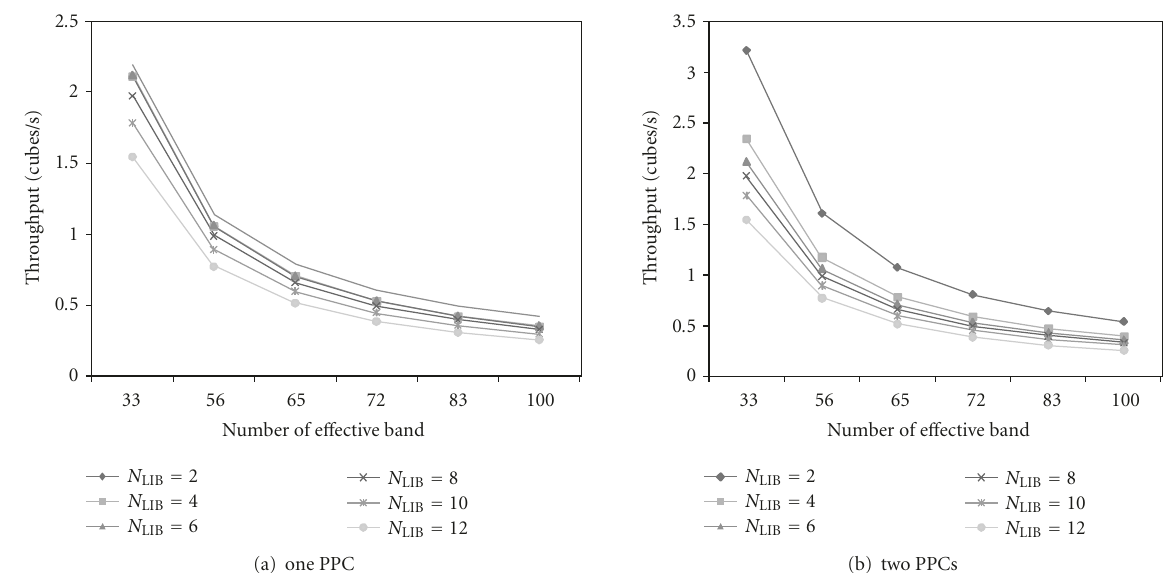
Figure 18: Illustration of throughput in terms of the number of e ff ective bands and libraries in 614 × 512 resolution and 224 band hyperspectral images.